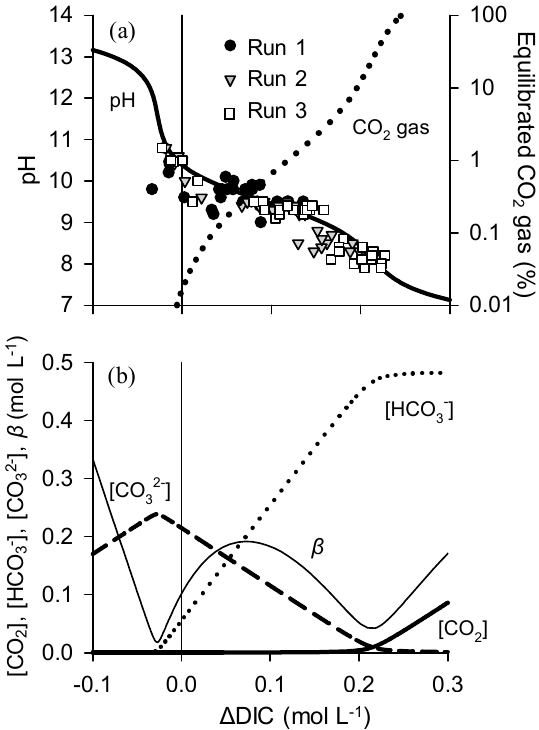
Figure 3. Estimation of ( a ) pH, ( b ) inorganic carbon species, and buffer capacity β , from change in dissolved inorganic carbon ( Δ DIC). All data points were from absorption columns. Δ DIC was calculated by subtracting the initial dissolved inorganic carbon (DIC) (ca. 0.27 mol L –1 ) from respective DIC on each day.